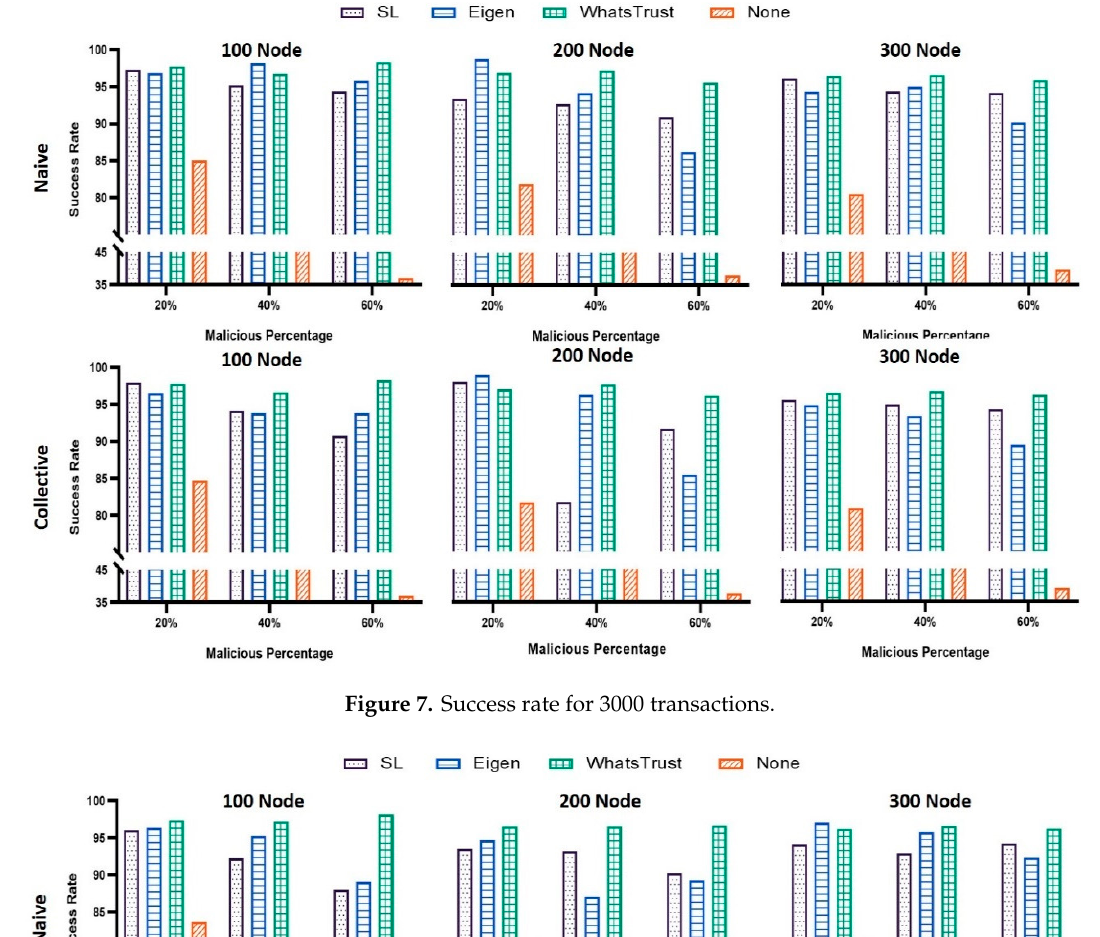
Figure 6. Success rate for 2000 transactions.